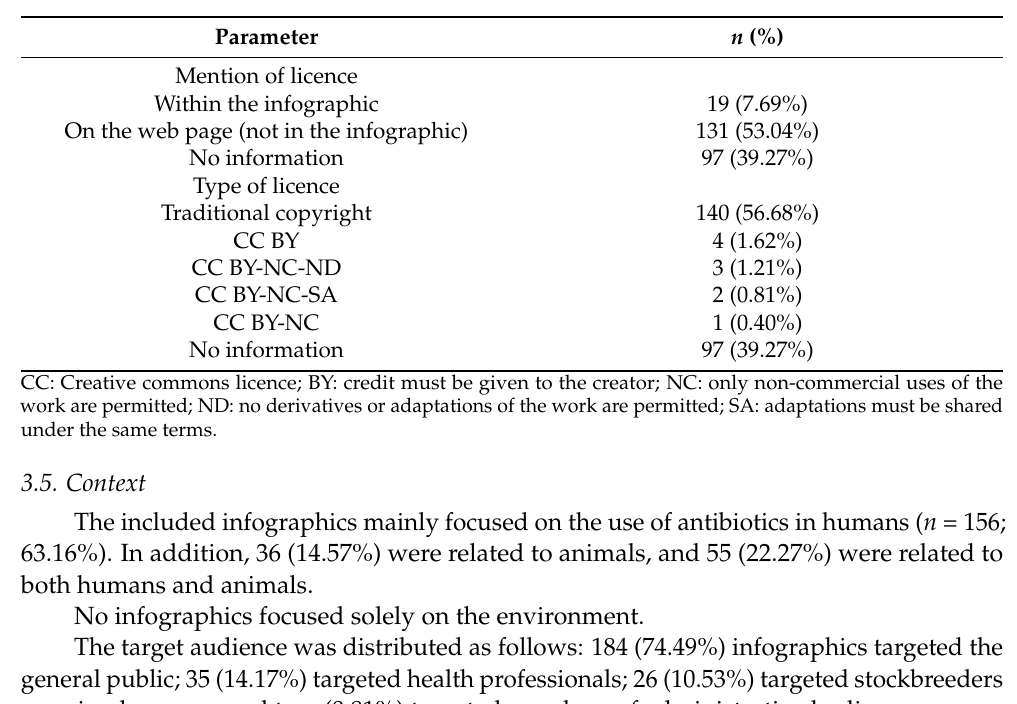
Table 4. Mention of licence and types of copyright licences in the included infographics.